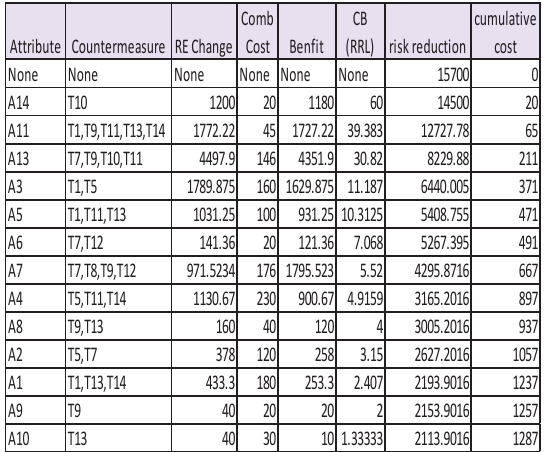
Table 6 : Experiment#1 Output Sample Attribute Countermeasure RE Change